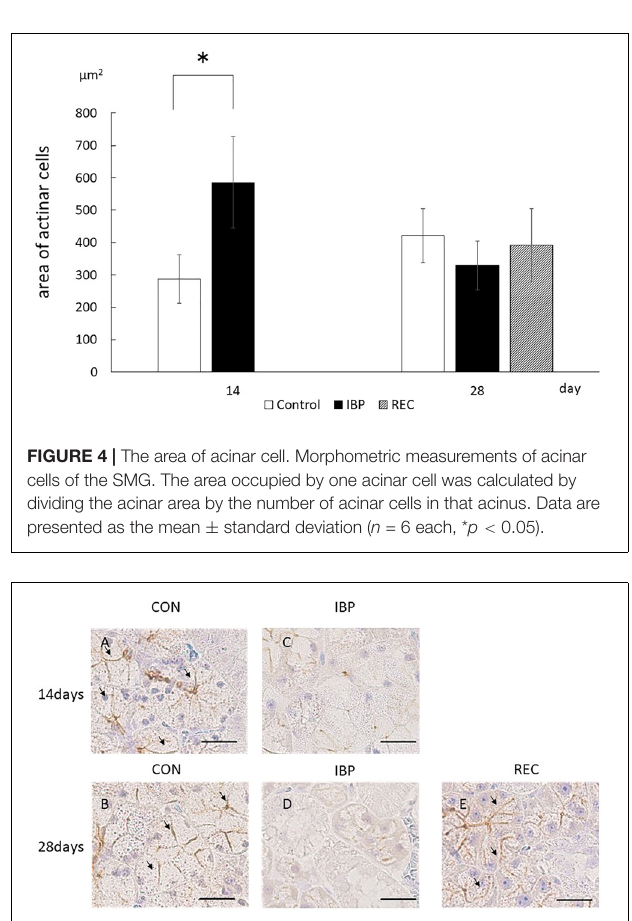
FIGURE 5 | Immunohistochemical images of AQP5 expression. (A,B) CON group; AQP5 was detected on the apical plasma membrane (APM) and in the intercellular secretory canaliculi of acinar cells and on the luminal side of the intercalated duct. (C,D) IBP group; immunostaining of AQP5 in the APM and intercellular secretory canaliculi of acinar cells; almost no staining was observed in the APM of the acinar cells. (E) REC group; AQP5 was detected at the same level as that of the CON group. AQP5, aquaporin 5; CON, control group; IBP, incisor bite plate group; REC, the recovery group.